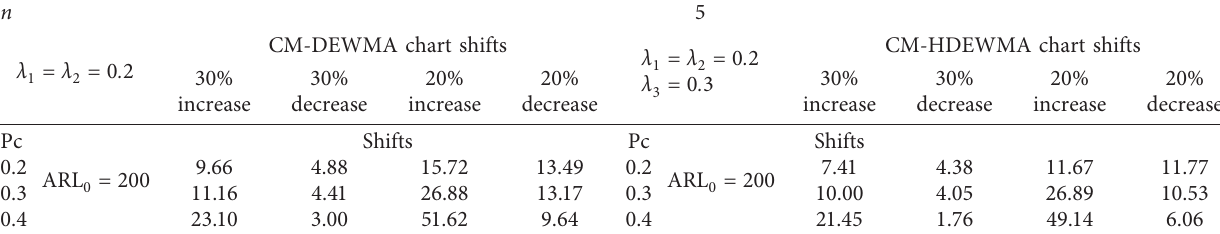
Table 8: Out-of-control ARL values for CM-HDEWMA and CM-DEWMA control charts for n � 5 with MLE α ⌢ � 0 . 91 , β � 1 . 5. n 5 � λ � 0 . 2 λ 1 2 � 0 . λ 3